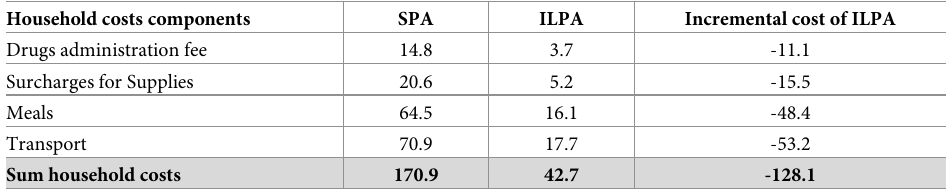
Table 3. Household cost components per patient treated (2017